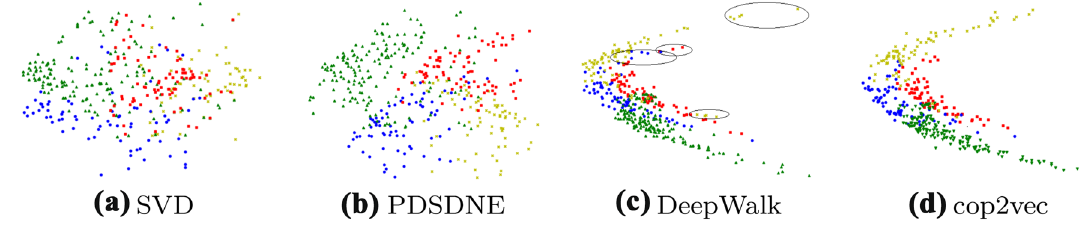
Fig. 7 Visualization of purchaser